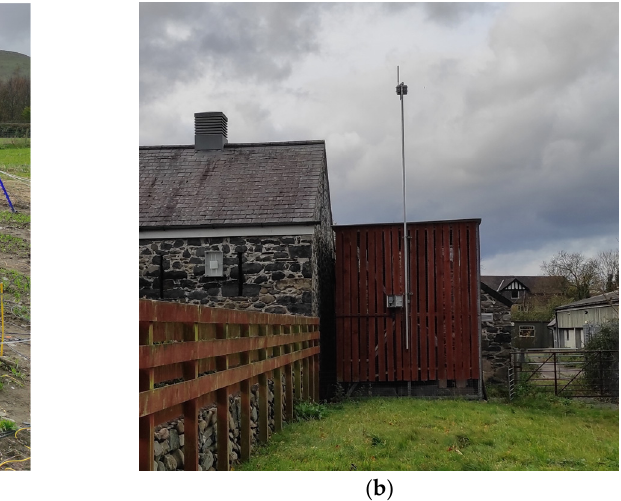
Figure 9. Overview of data processing.